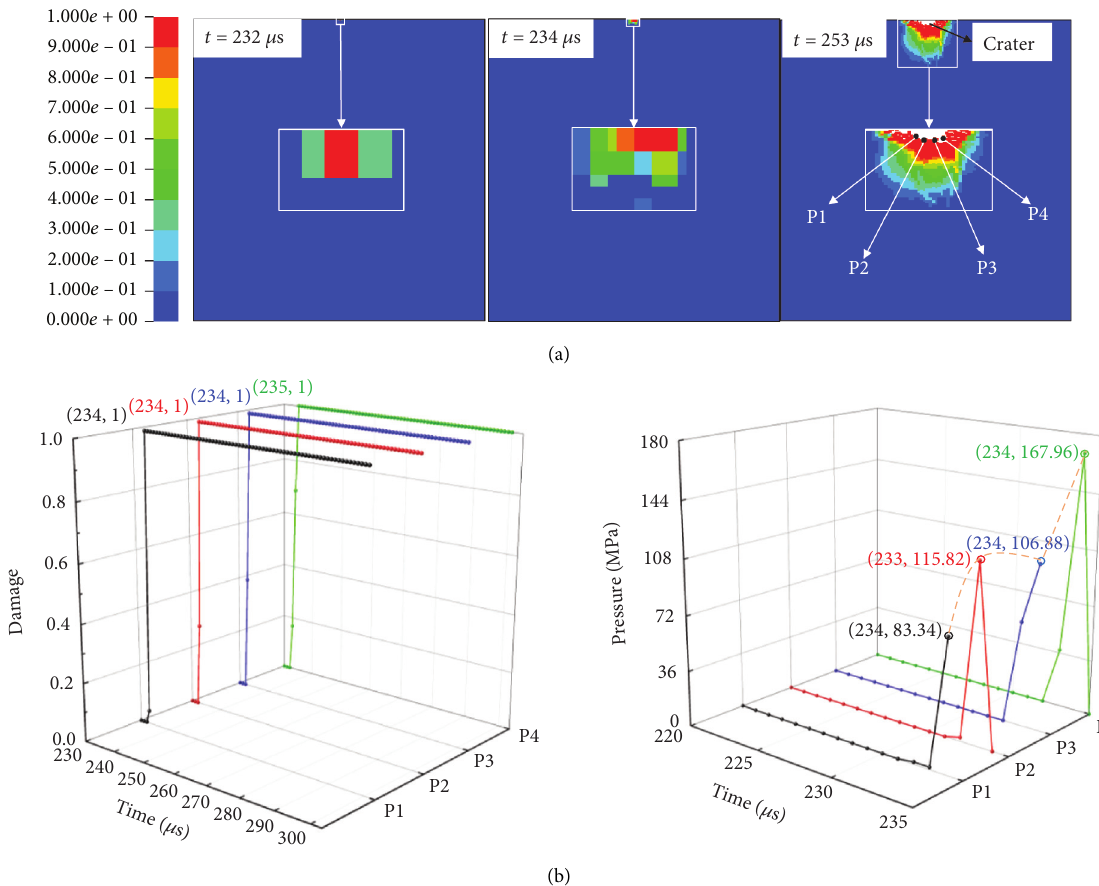
Figure 6: The formation of the crater. (a) The formation process of the crater. (b) Damage and pressure of particles in the liquid–solid contact